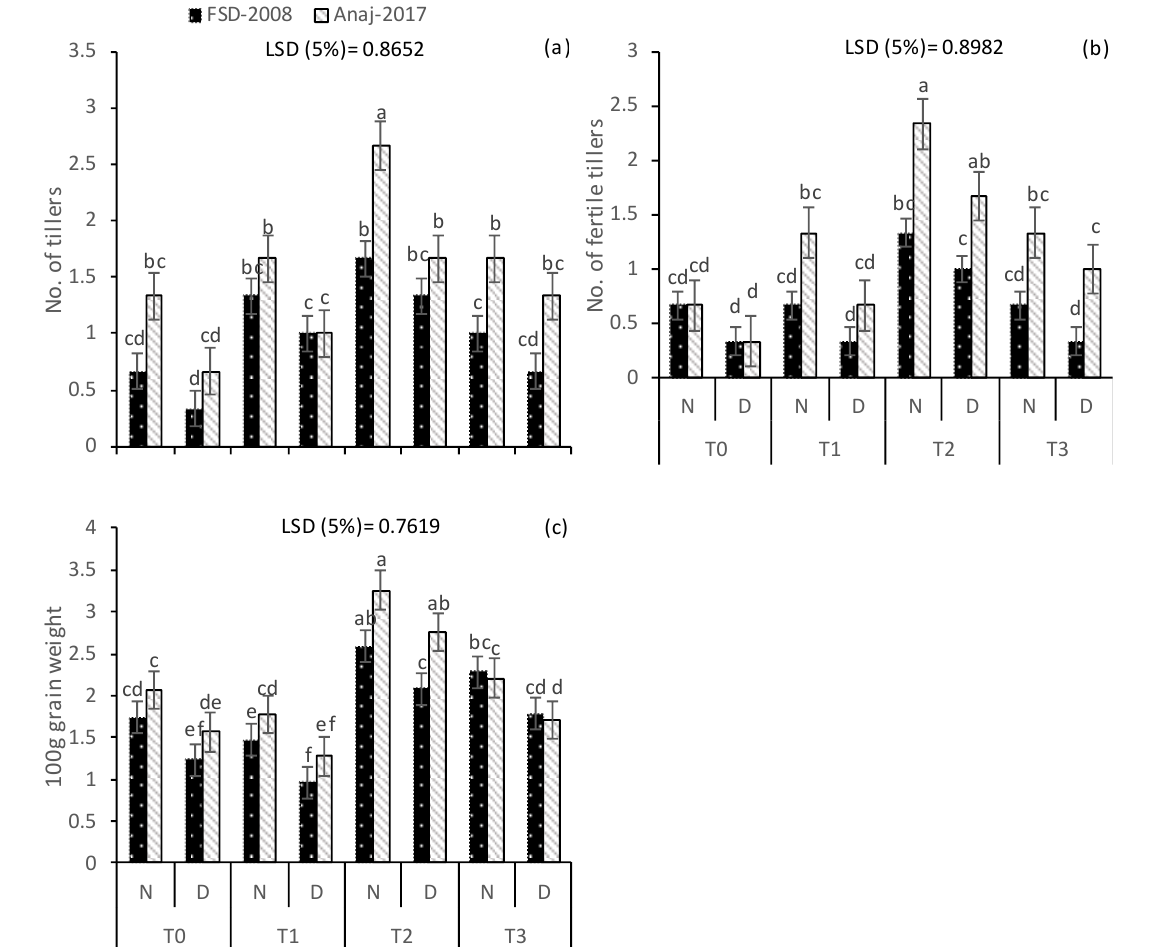
Figure 3. Effects of laser seed priming on ( a ) number of tillers, ( b ) number of fertile tillers and ( c ) 100 g grain weight in wheat under drought stress. Legend: N = Control (100% field capacity), D = Drought (50% field capacity), T0 = Unprimed control, T1 = 1 min laser priming, T2 = 2 min laser priming and T3 = 5 min laser priming. Means sharing same lowercase letters on bars are statistically non−significant at P ≤ 0.05%)